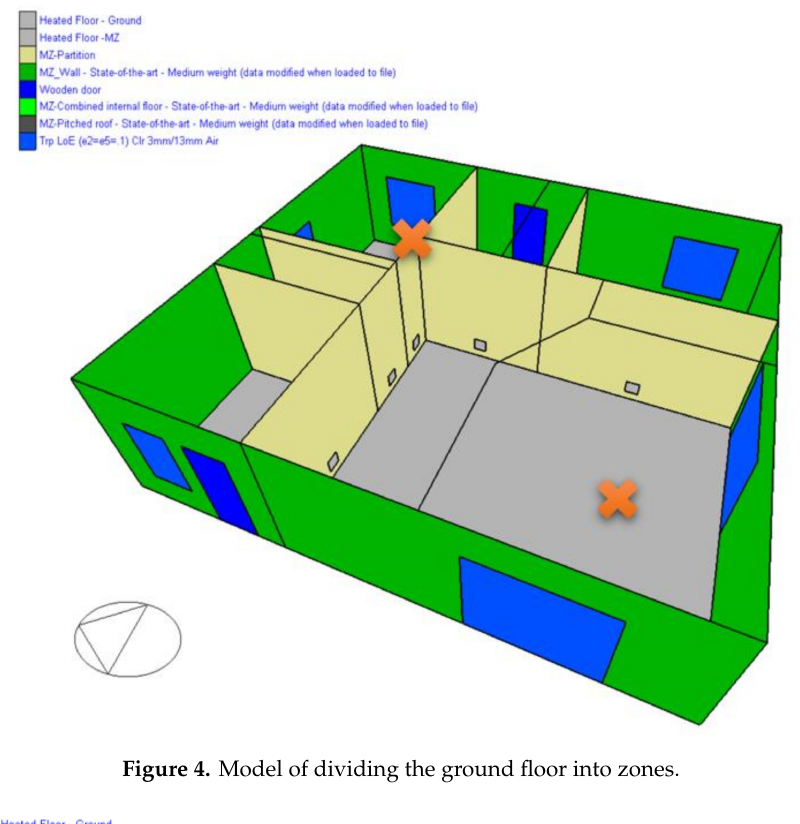
Figure 4. Model of dividing the ground floor into zones.